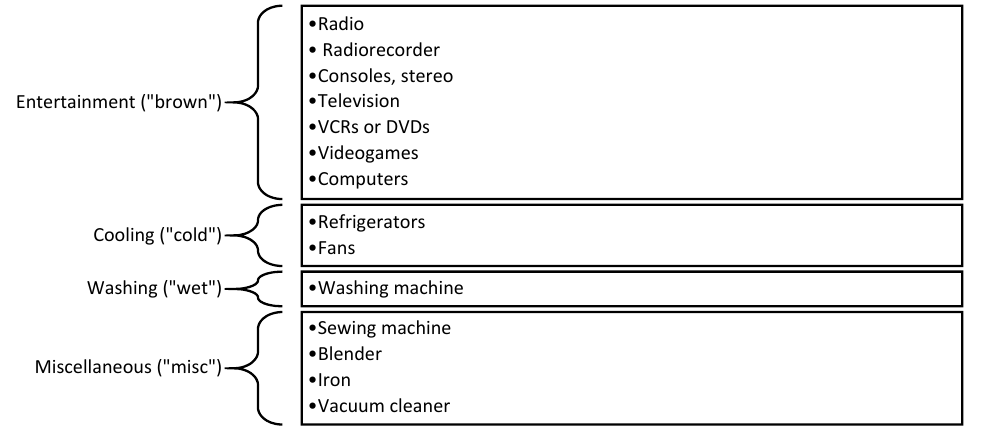
Figure 2. Appliances classification in the Mexican survey—ENIGH. 1992–2014. Source: Authors’ classification based on Yao and Steemers (2005).